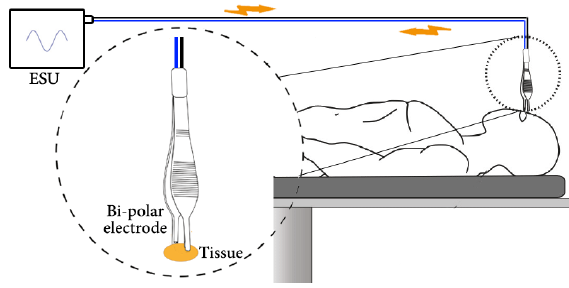
Fig.2: Bi - polar ESU